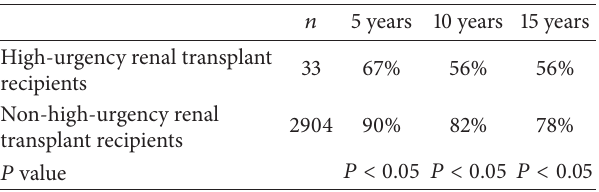
Table 3: Comparison of patient survival between HU and non-HU renal transplant recipients.